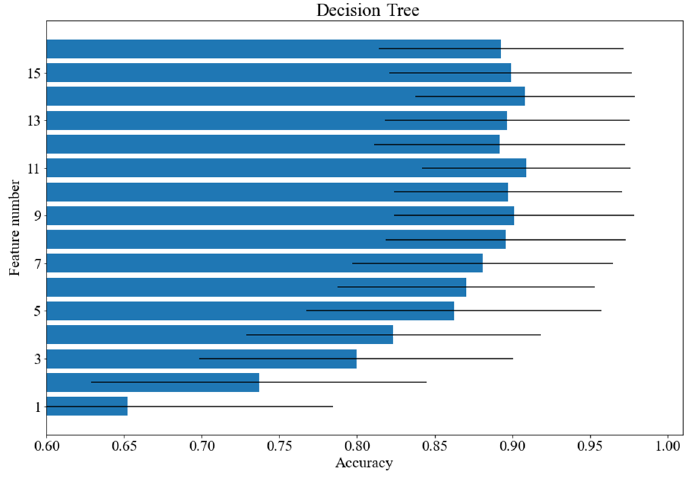
Figure 4. Accuracy scores for various number of features: decision tree.